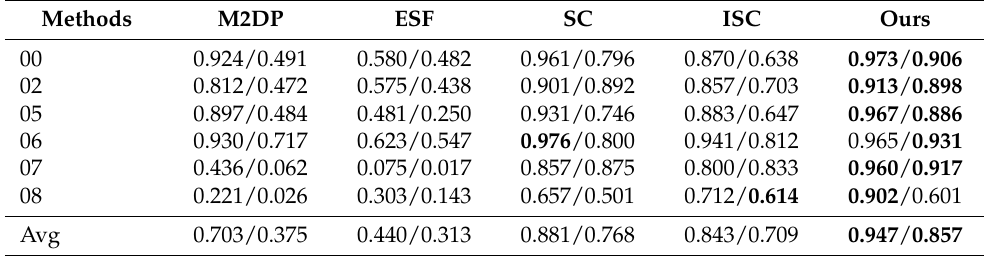
Table 1. F1 max scores and EP on KITTI